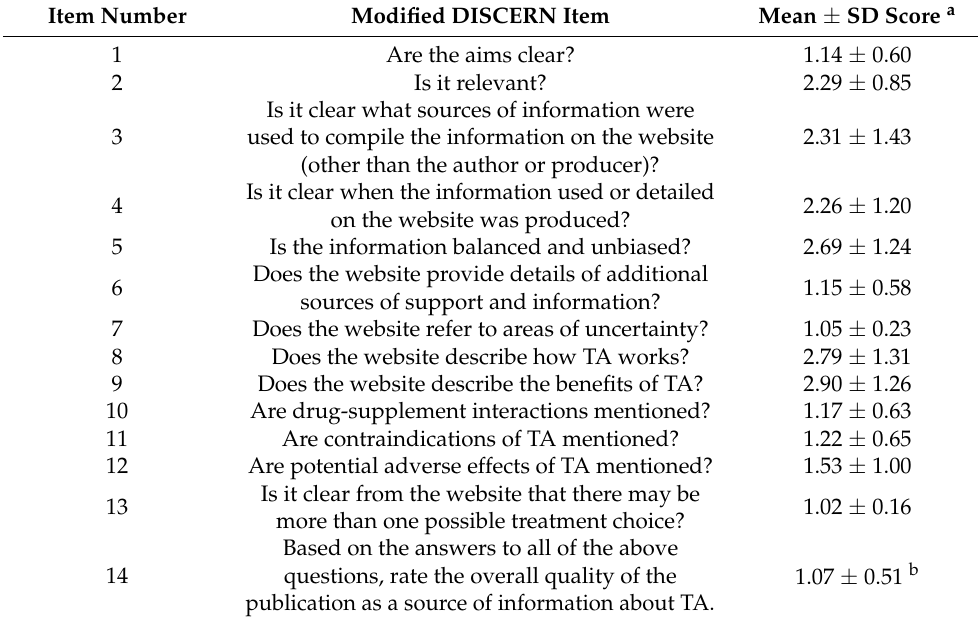
Table 1. Rating score for each of the modified DISCERN